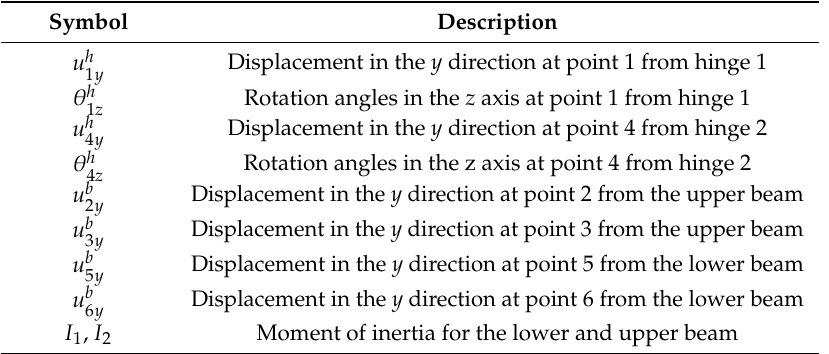
Table 2. All variables are used in the above flexure